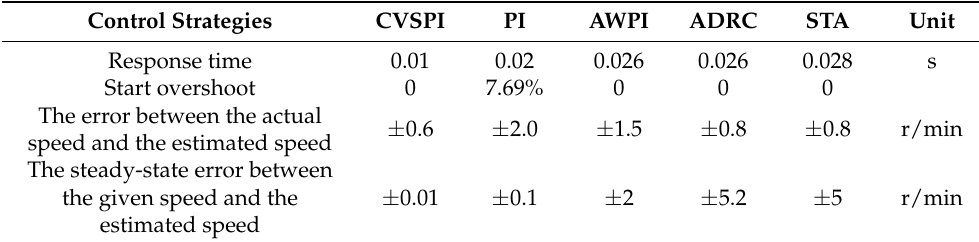
Figure 8. ( a ) Estimated and actual rotational speeds for the first sine case. ( b ) The speed error for the first sine case. ( c ) Estimated and actual rotational speeds for the second sine case. ( d ) The speed error for the second sine case. Table 2. Performance comparison with a peak of 300 r/min, a trough of 200 r/min, and a frequency of 5